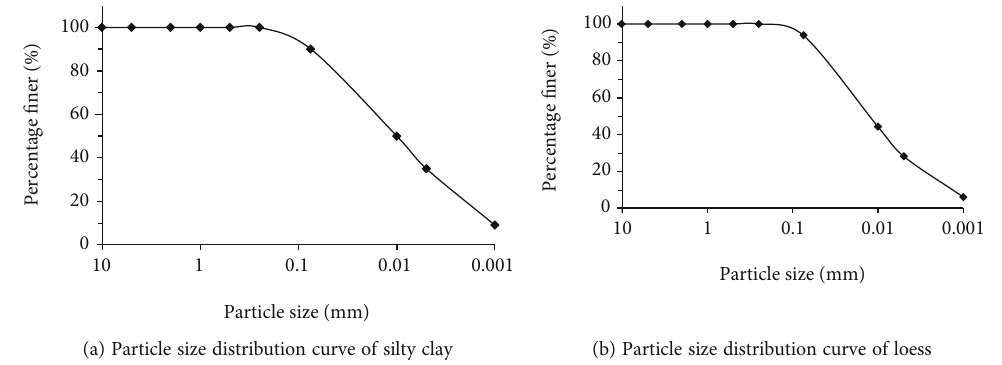
(b) Particle size distribution curve of loess Figure 3: Particle size distribution curve of soil samples.